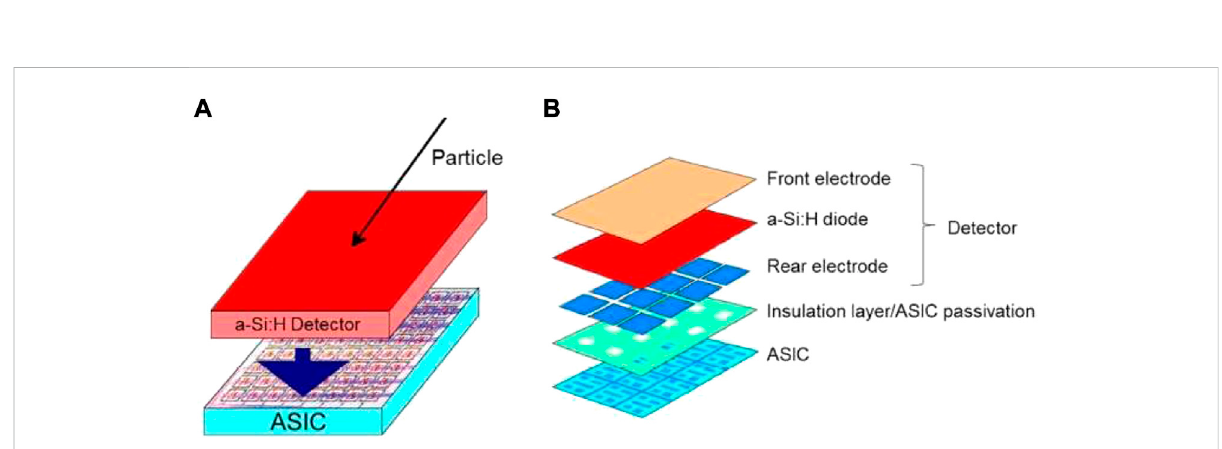
FIGURE 2 (A) Schematic design of integration of planar detector with the readout chip. (B) Exploded view of the detector plus readout chip assembly.